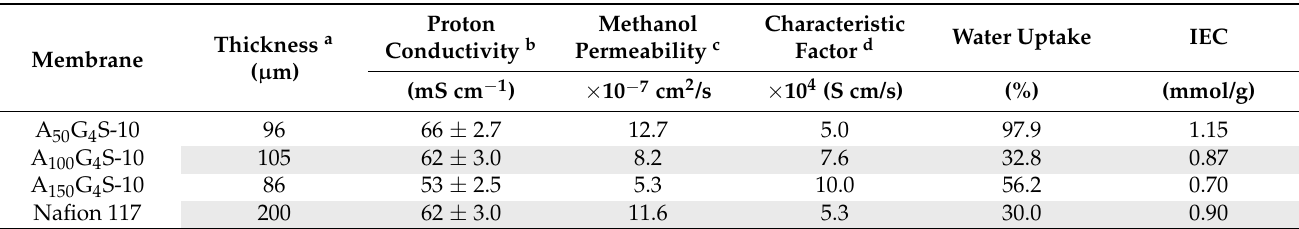
Table 2. Comparison of proton exchange membrane (PEM) properties between the cross-linked diblock ionomer membranes and Nafion 117